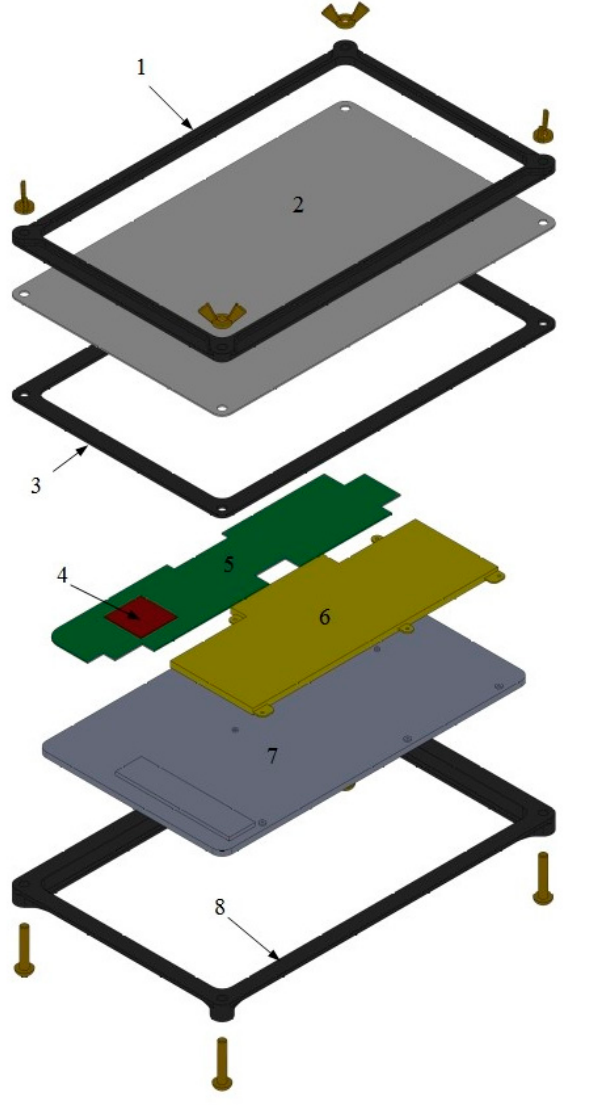
Figure 1. Rendering showing an exploded view of the mock tablet.